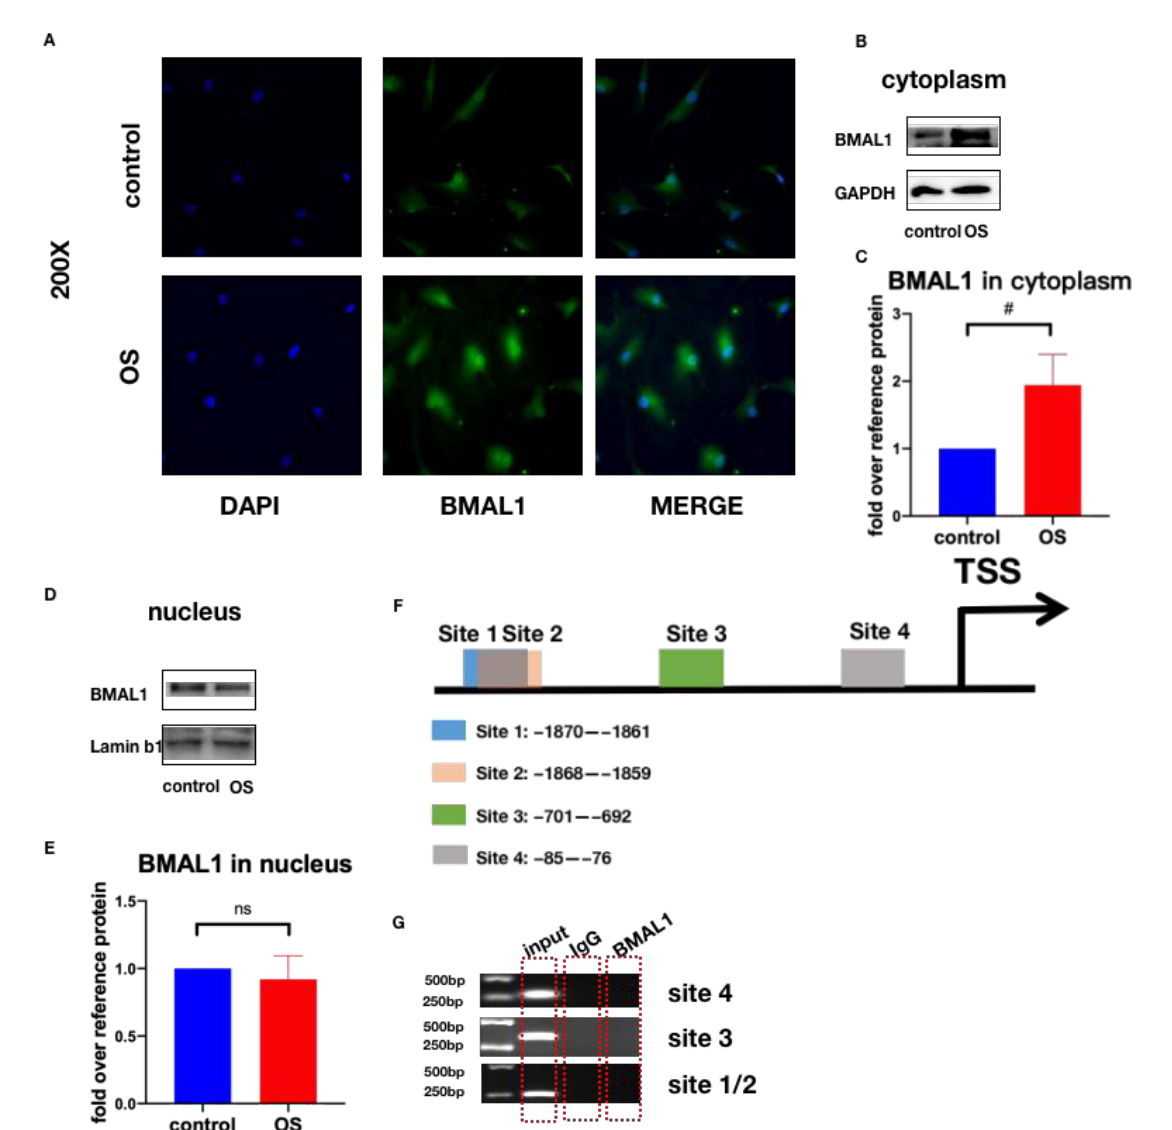
Figure 5. BMAL1 cannot act as a transcription factor in regulating osteogenic differentiation of HVICs. ( A ) representative images of immunofluorescence staining of BMAL1 in HVICs in normal and osteogenic medium. ( B , C ) BMAL1 expression was increased in cytoplasm when HVICs were incubated with osteogenic medium, with n = 6 for each group. ( D , E ) no changes in the protein expression of BMAL1 in nucleus could be found when HVICs were incubated with osteogenic medium, with n = 6 for each group. ( F ) 4 predicted binding sites on runx2 promoter CPG region using JASPAR database. ( G ) ChIP detection of four possible binding sites, and BMAL1 could not bind with runx2 promoters. # p < 0.01, OS, osteogenic